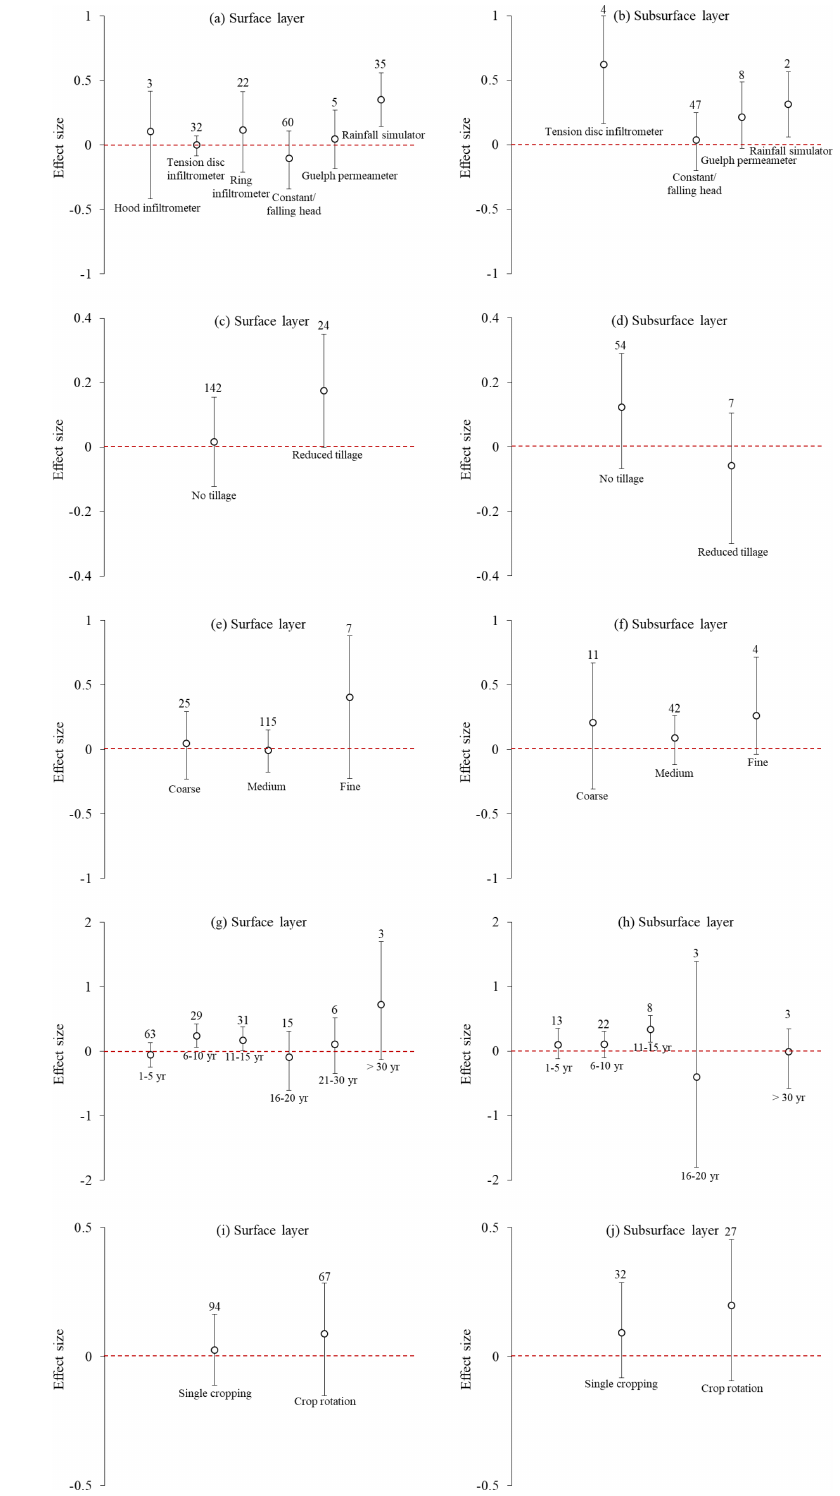
Figure 3. Factors influencing the effect sizes of the surface and subsurface saturated hydraulic conductivity under conservation tillage (CS) from a global meta-analysis of 69 studies, including the (a, b) measurement technique, (c, d) conservation tillage type, (e, f) soil texture type, (g, h) time since conversion, and (i, j) cropping system management. The error bars indicate effect sizes and 95% bootstrap confidence intervals (CIs). The effect of CS was statistically significant if the 95% CI did not bracket zero. The sample size for each variable is shown next to the bar. SOIL, 8, 309–317, 2022